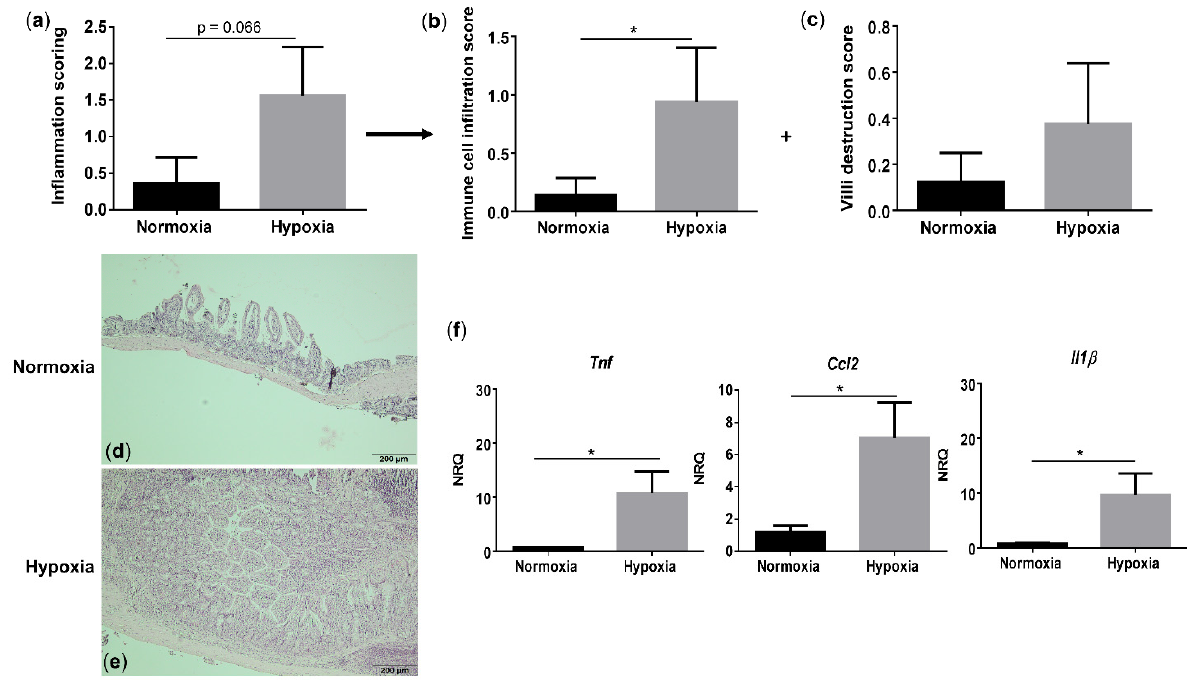
Figure 4. Long-term environmental hypoxia exposure in WT mice induces a proinflammatory ileal microenvironment. ( a ) Total histological inflammation score in WT mice housed in normoxia and hypoxia, comprising the subscores, ( b ) immune cell infiltration and ( c ) villi destruction. Representative images from haematoxylin-eosin (H&E) sections of the distal ileum from ( d ) a WT mouse housed in normoxia and ( e ) a WT mouse housed in hypoxia. ( f ) mRNA expression levels of Tnf , Ccl2 and Il1 β in WT littermates housed in normoxia and hypoxia. * p < 0.05. Data are represented as the mean ± SEM. NRQ: Normalized relative quantities.